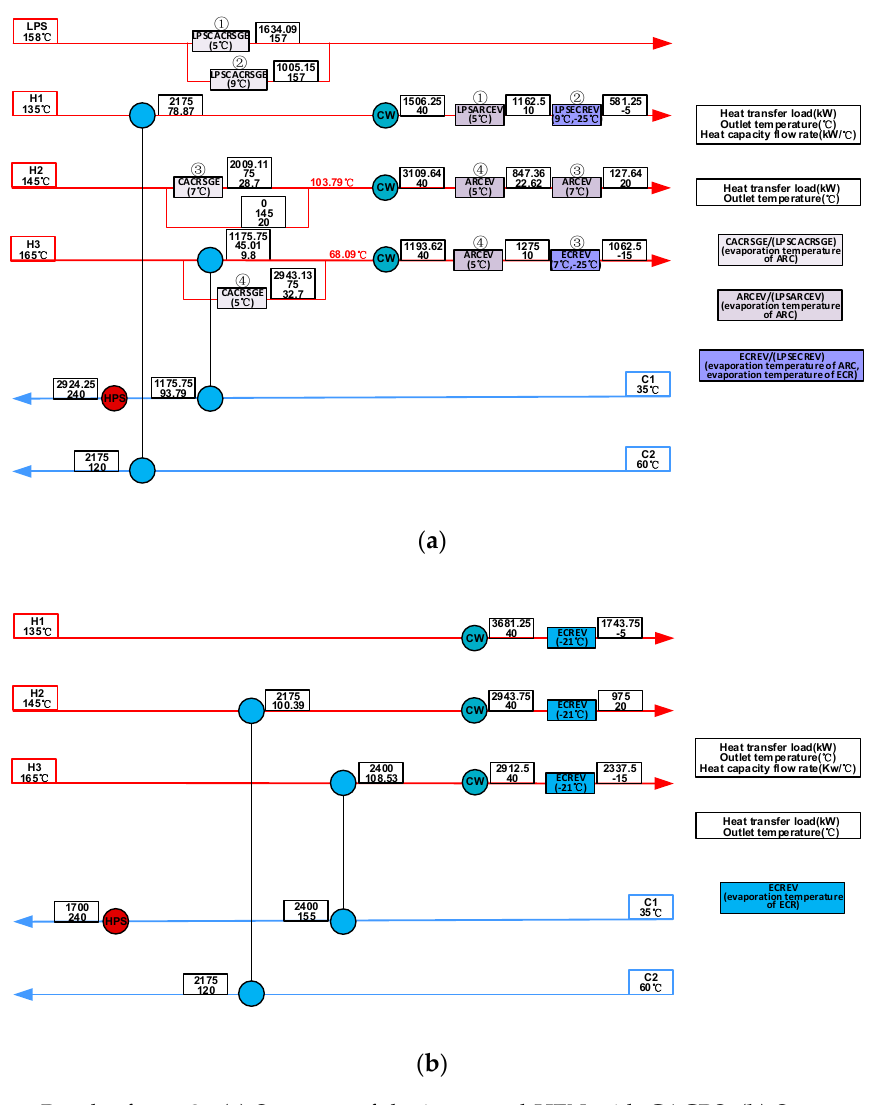
Figure 5. Result of case 2. ( a ) Structure of the integrated HEN with CACRS; ( b ) Structure of the integrated HEN with ECR.